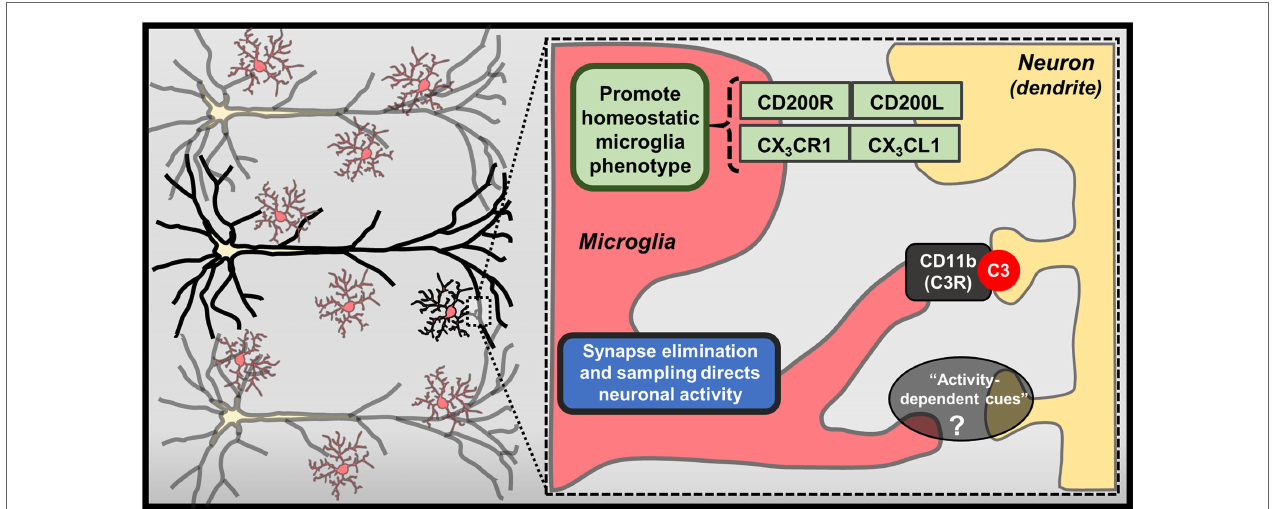
FiGURe 2 | Contact-dependent mechanisms mediating neuron–microglia interactions . Physical interactions between neurons and microglia exist, including membrane-bound CX 3 CL1 and CD200L, which bind CX 3 CR1 and CD200R on microglia, respectively. Further recent studies have highlighted specialized mechanisms that contribute to contact-dependent synaptic modulation, such as binding of complement component C3 to synapses and eventual removal of these “tagged” synapses by microglia through CD11b/CR3-mediated phagocytosis. Microglia can also envelop hyperactive neurons and regularly perform “synapse sampling” via activity-dependent mechanisms that are not entirely defined